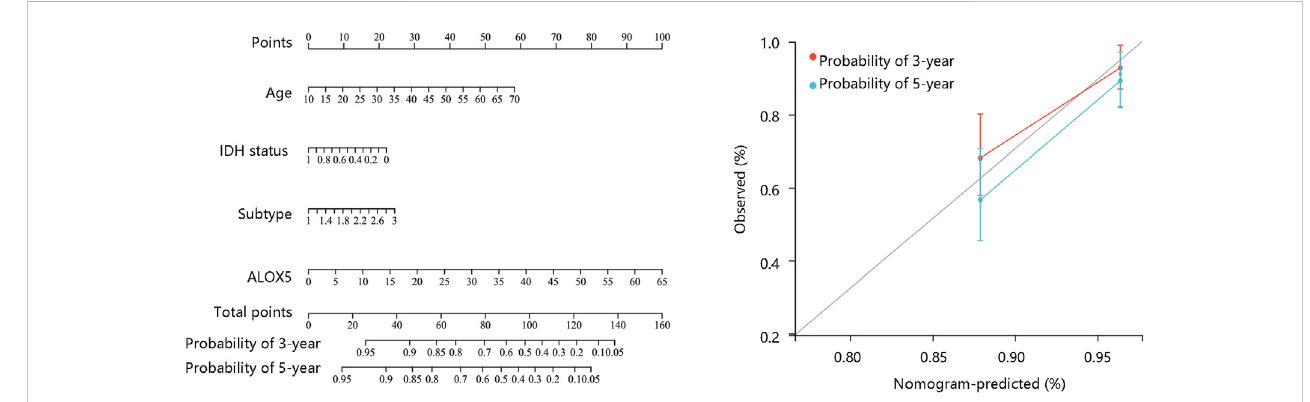
FIGURE 6 Nomogram construction and evaluation based on the multivariate Cox regression analysis results using the CGGA-LGG data.